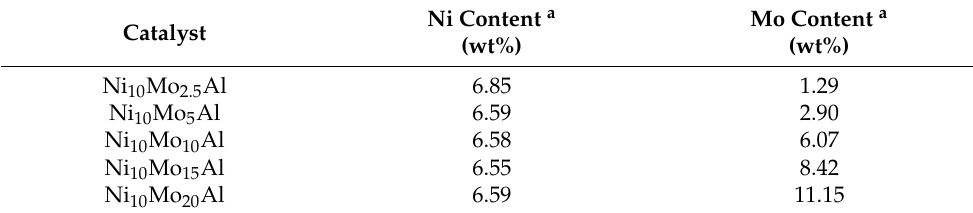
Table 1. ICP–OES results for the fresh Ni 10 Mo x Al catalysts.